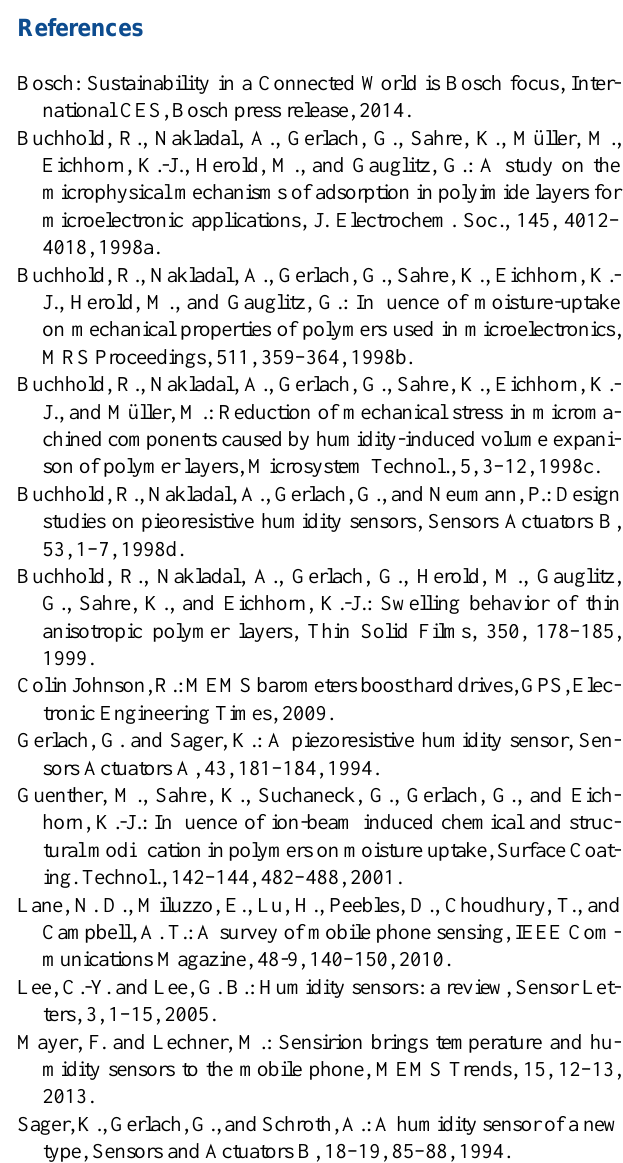
Fig. 13 a scanning electron microscope picture of the